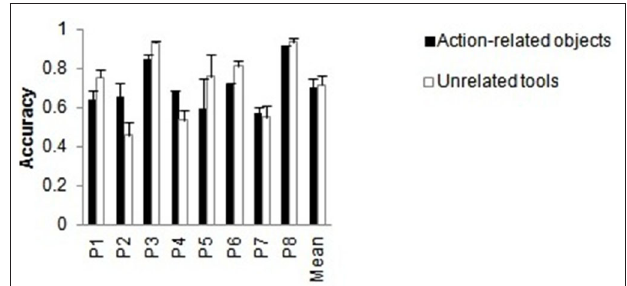
FIGURE 6 | Action-related objects vs. unrelated tools, with a broken tool handle. Mean patient accuracies as a function of the pair condition, averaged across the side of the broken tool. Error bars denote